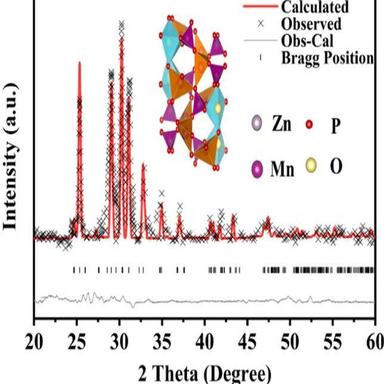
X-ray diffraction (XRD) pattern and the Rietveld refinement. The inset is the schematic diagram of crystal structure.